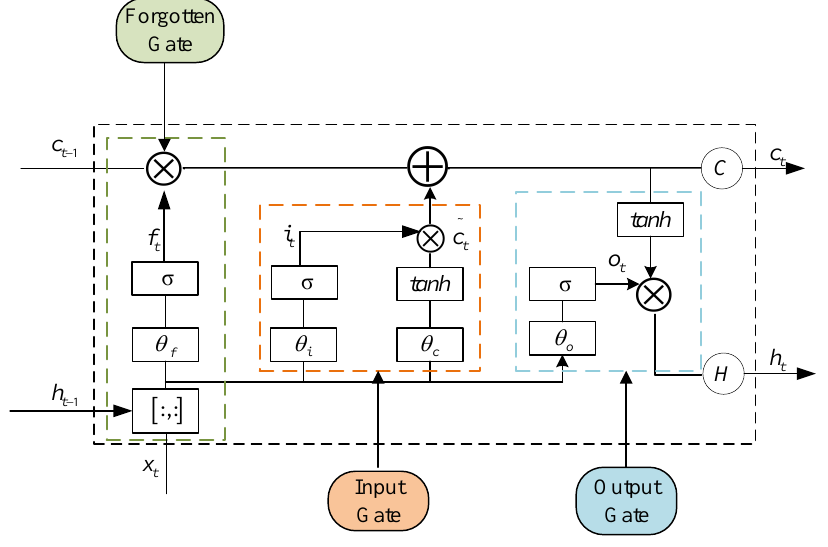
Figure 2. LSTM cell